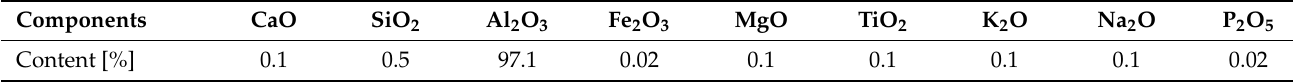
Table 5. Chemical composition of corundum.